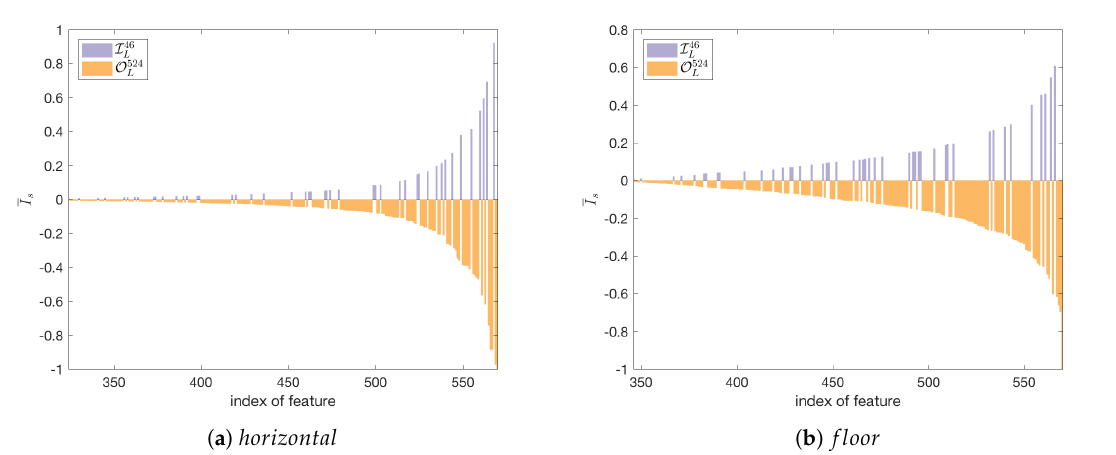
Figure 6. The importance of Wi-Fi APs calculated separately for horizontal localisation ( a ) and floor detection ( b ).